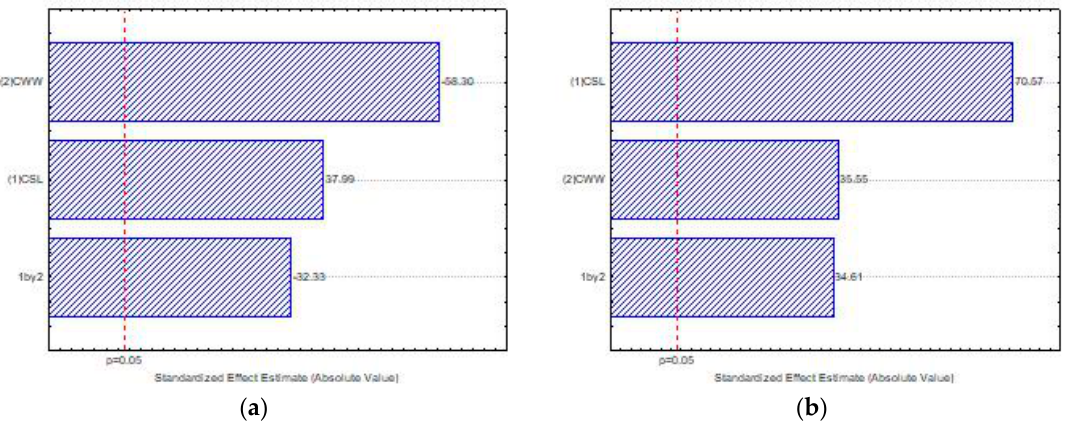
Figure 5. Pareto chart of standardized effects of CSL (1) and CWW (2) on the chitosan production by Mucor subtilissimus (UCP 1262) ( a ) and Lichtheimia hyalospora (UCP 1266) ( b ).